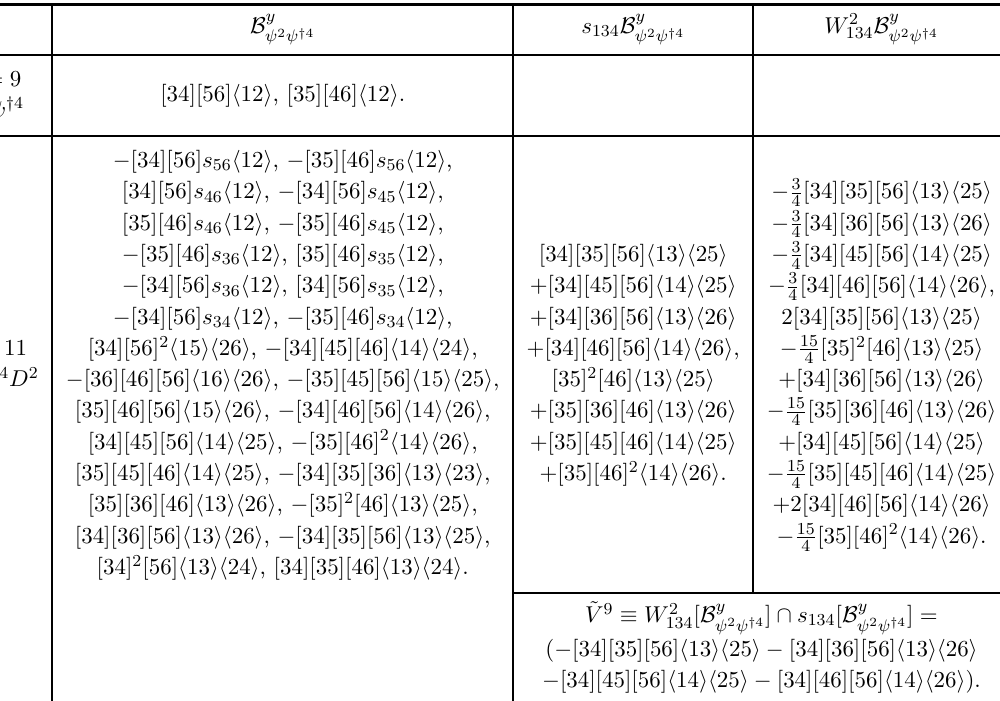
¯ ψ 4 at partition { 134 | 256 }